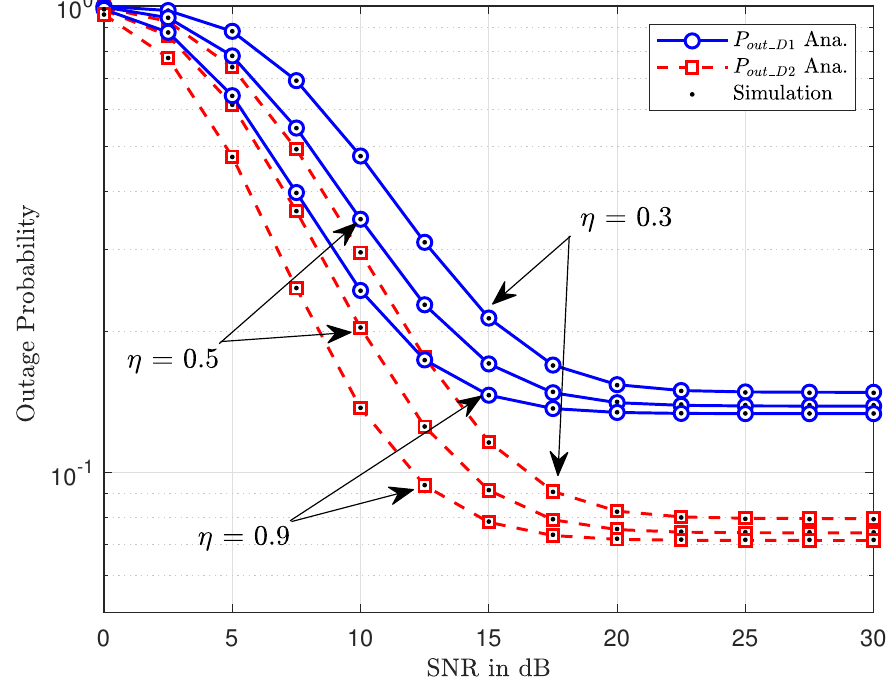
Figure 4. Impact of percentage of harvested power at RSU on outage performance.